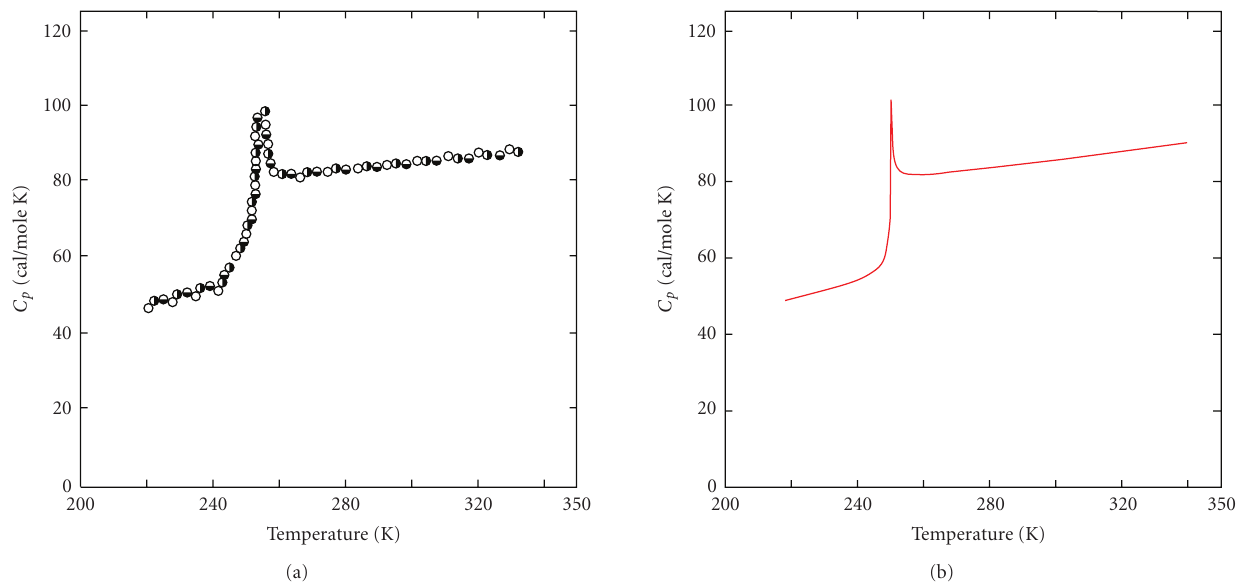
Figure 1: Specific heat of amorphous o -terphenil. (a) Experimental and (b) calculated [12].